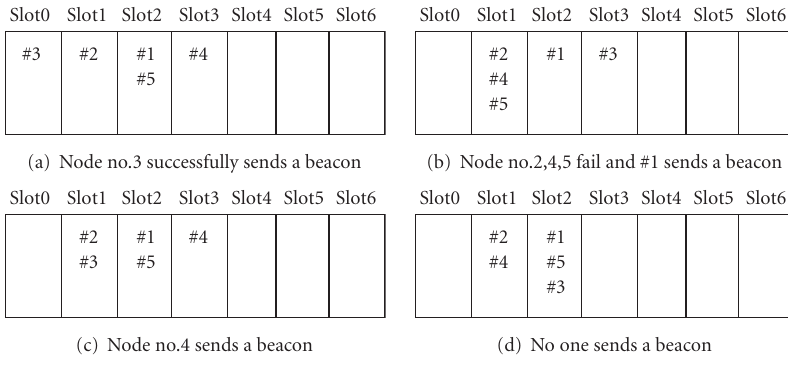
Figure 1: Slot allocation and transmission